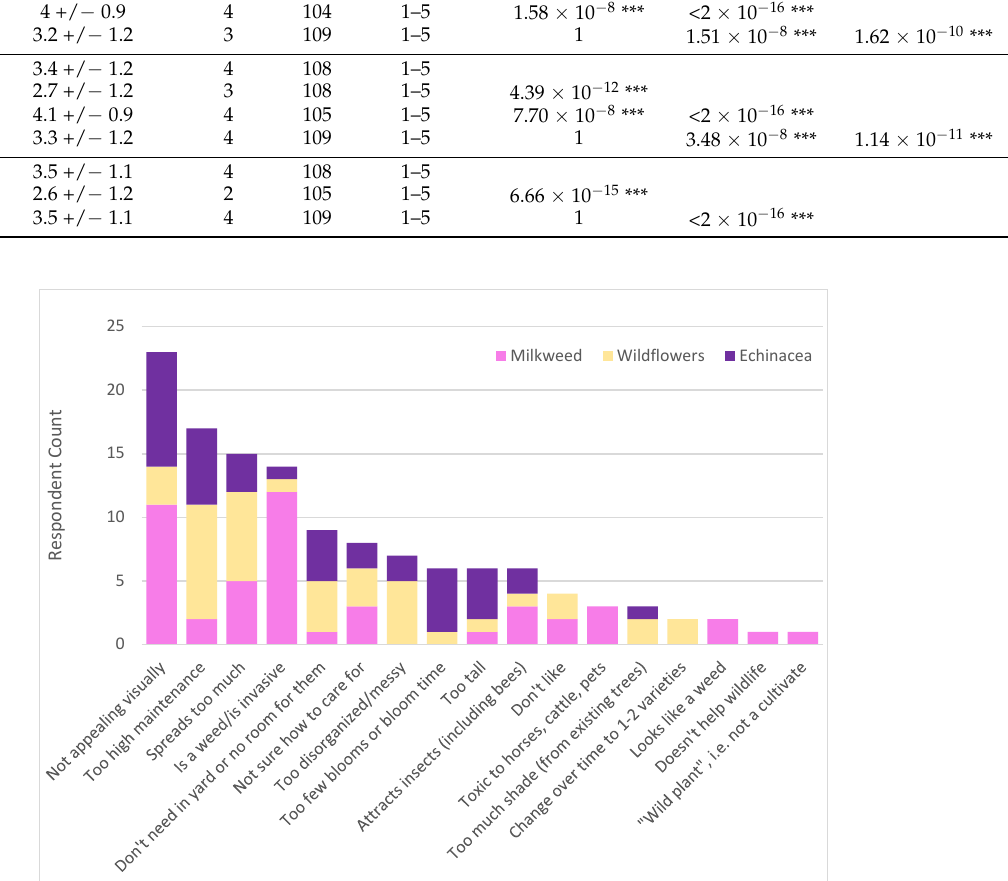
Figure 2. Key barriers to adding the pollinator beneficial plants shown in the survey. Number of times (counts) a respondent stated a particular reason as to why they might not like to add Asclepias syriaca (Common Milkweed; pink bars), Echninacea purpurea (purple coneflower; purple bars), or wildflowers (multiple spp .; orange bars) to their yard. This was an open-ended question on the survey instrument. Out of the 113 respondents to the survey, 48 chose to write at least one reason down in the answer box provided for that purpose for E. purpurea , 57 for A. syriaca , and 54 for wildflowers.